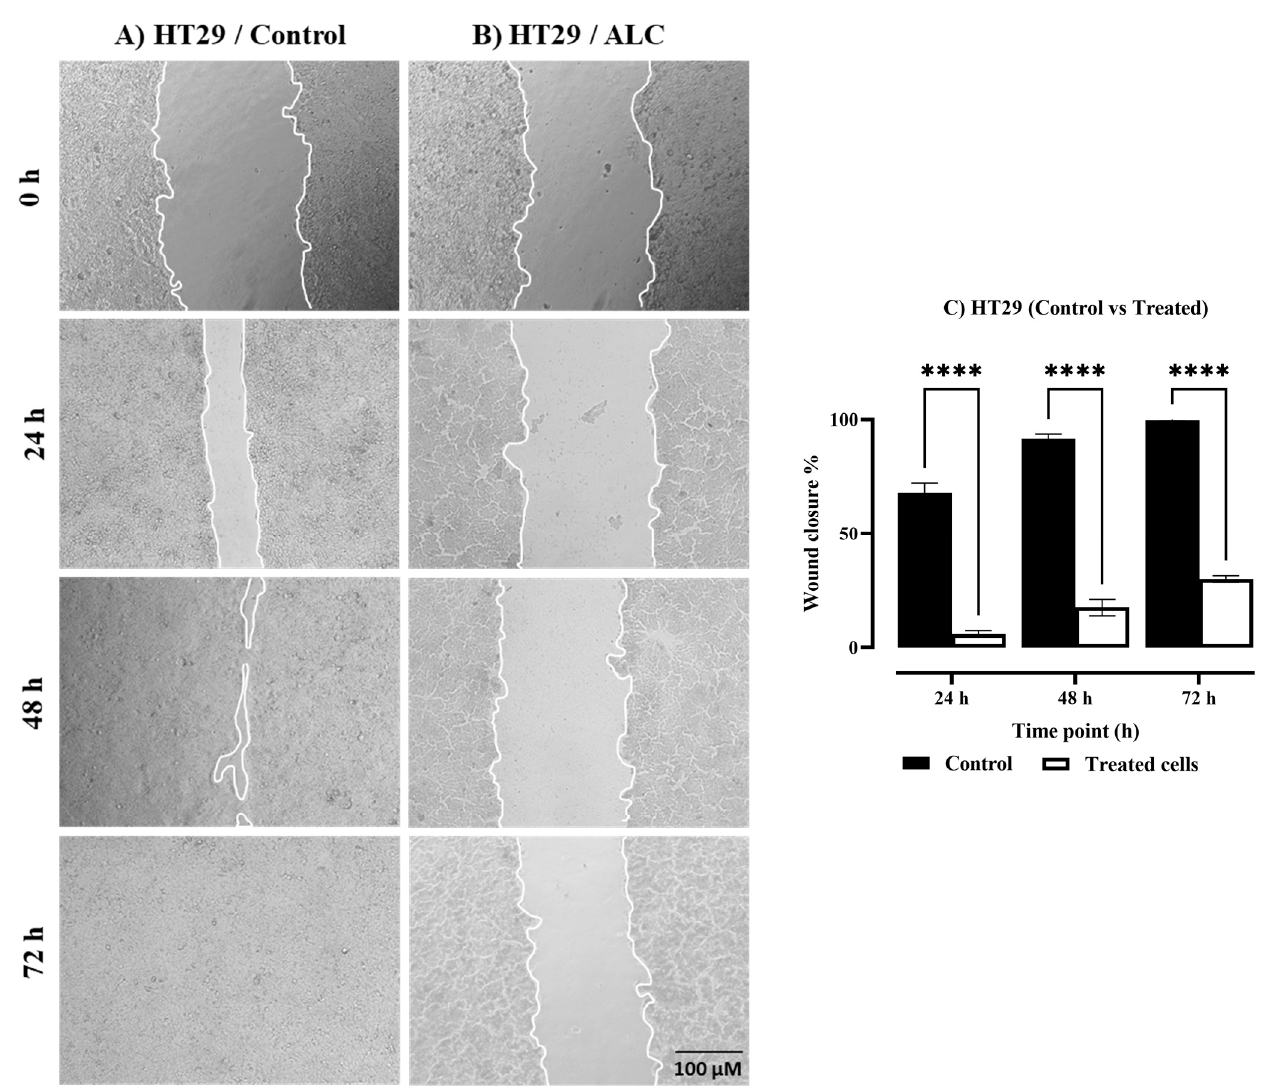
Figure 3. The effect of ALC treatment on wound closure in HT29 cells at 0, 24, 48, and 72 h. ( A ) Control HT29 cells, ( B ) ALC-treated HT29 cells. HT29 cells were treated with their IC 50 concentrations of ALC, and brightfield images were acquired at 0, 24, 48, and 72 h using an inverted microscope with a 10× objective lens. ( C ) A summary of the wound-healing assay's findings. ImageJ was used to measure the wound closure percentage. Two-way ANOVA analysis was performed to compare the wound closure percentage for control vs. treated cells. The error bars correspond to SD, **** p < 0.0001.